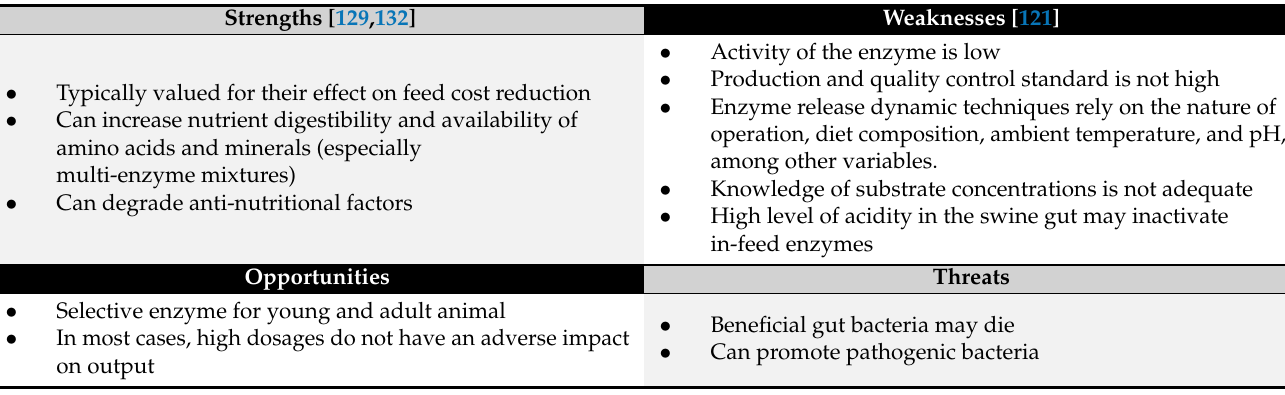
Table 4. SWOT analysis of